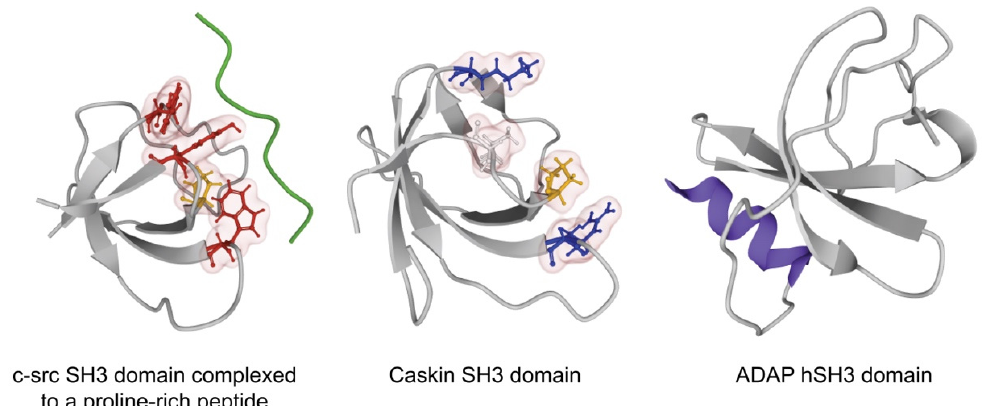
Figure 3. Comparison of lipid binding SH3 domains. The prototype c-src SH3 domain employs key aromatic (red) and proline (yellow) residues for binding proline-rich motifs of their partner (green). The Caskin SH3 domain traded off the three key aromatic residues for basic (blue) and hydrophobic (white) ones. The hSH3 domain of ADAP features an N-terminal helix (bue) rich in basic amino acids. We used the RCSB PDB database (www.rcsb.org) for the source of SH3 domain structure representations.